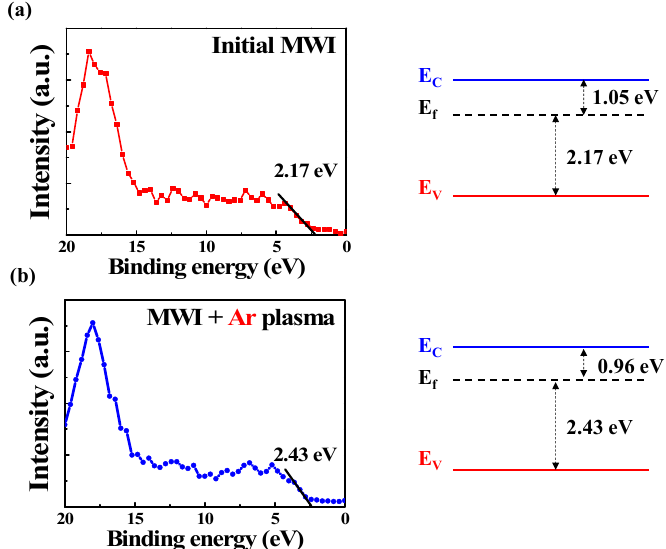
Figure 8. XPS valence band spectra and energy band structure of MWI ITO films ( a ) before and ( b ) after Ar plasma treatment.